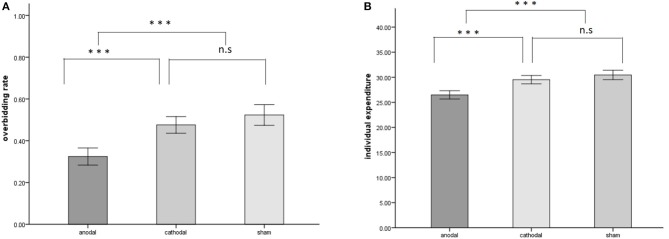
Stimulation effects (anodal/cathodal vs. sham) on the overbidding rate (A) and individual expenditures (B) across all periods. A significant main effect of both overbidding rate and individual expenditures was observed, driven by the difference between the anodal condition and other conditions. Error bars depict SD of the mean, ***p < 0.001.